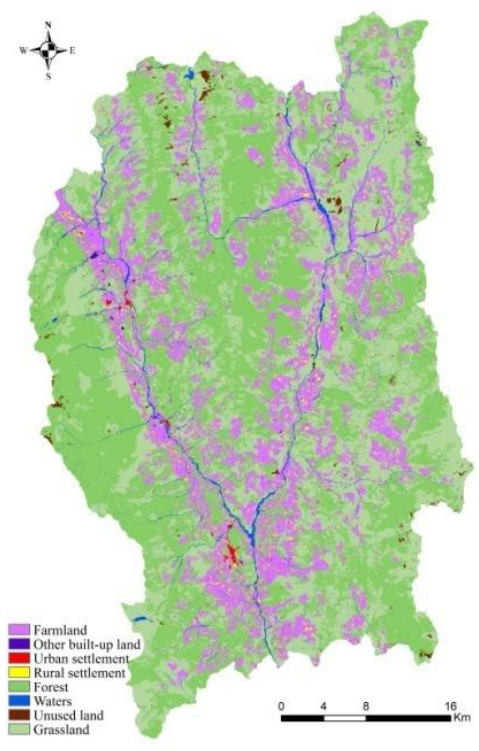
Figure 8. Actual distribution map of land use in Puge County in 2017.